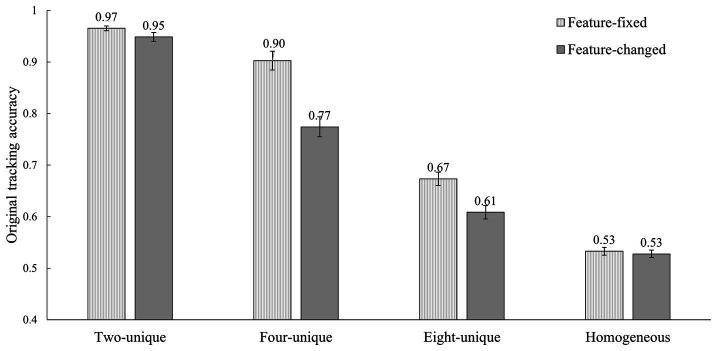
The tracking accuracies of the eight conditions in Experiment 1 (error bars show ±1 standard error of the mean).